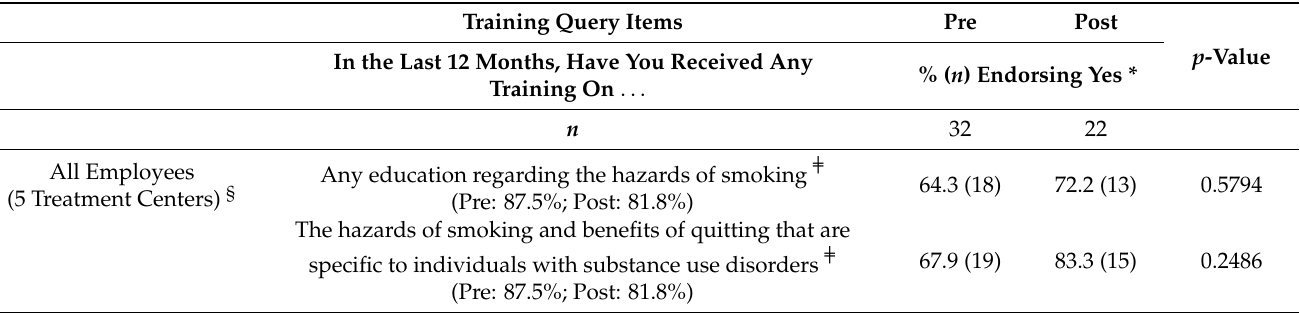
Table 2. Training receipt from pre- to post-implementation among responding employees and clinicians in opioid addiction treatment centers.